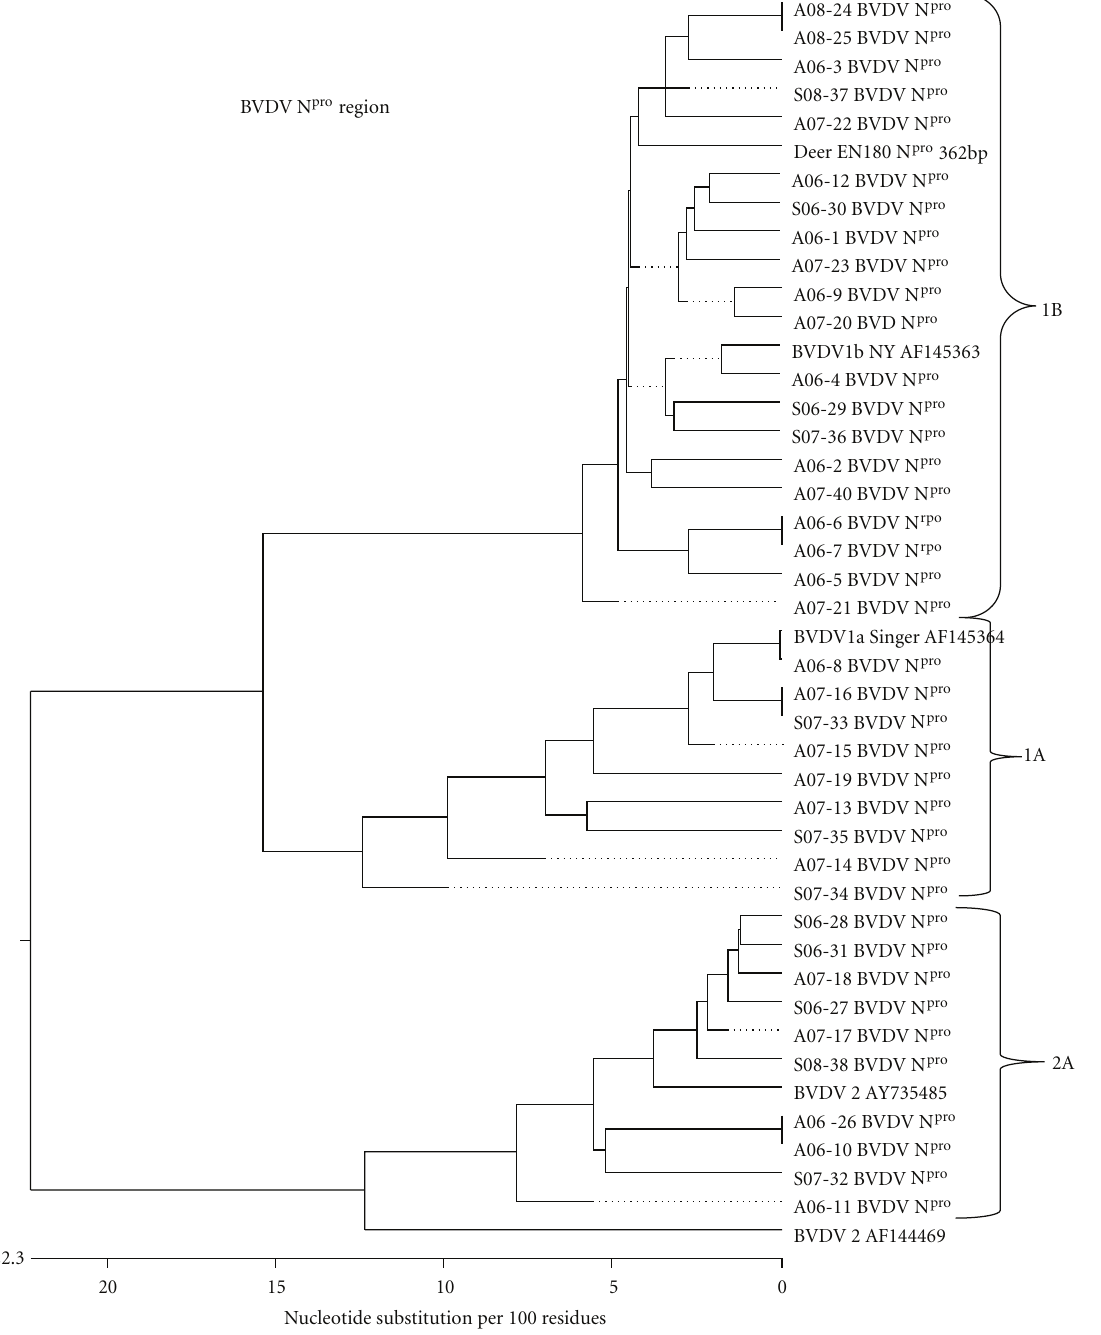
Figure 2: Phylogenetic tree of pestiviruses sequenced at N pro region from cattle isolated from samples submitted to the Indiana Animal Disease Diagnostic Laboratory between 2006 and 2008 compared to reference BVD viruses constructed by DNASTAR program, using Clustal W